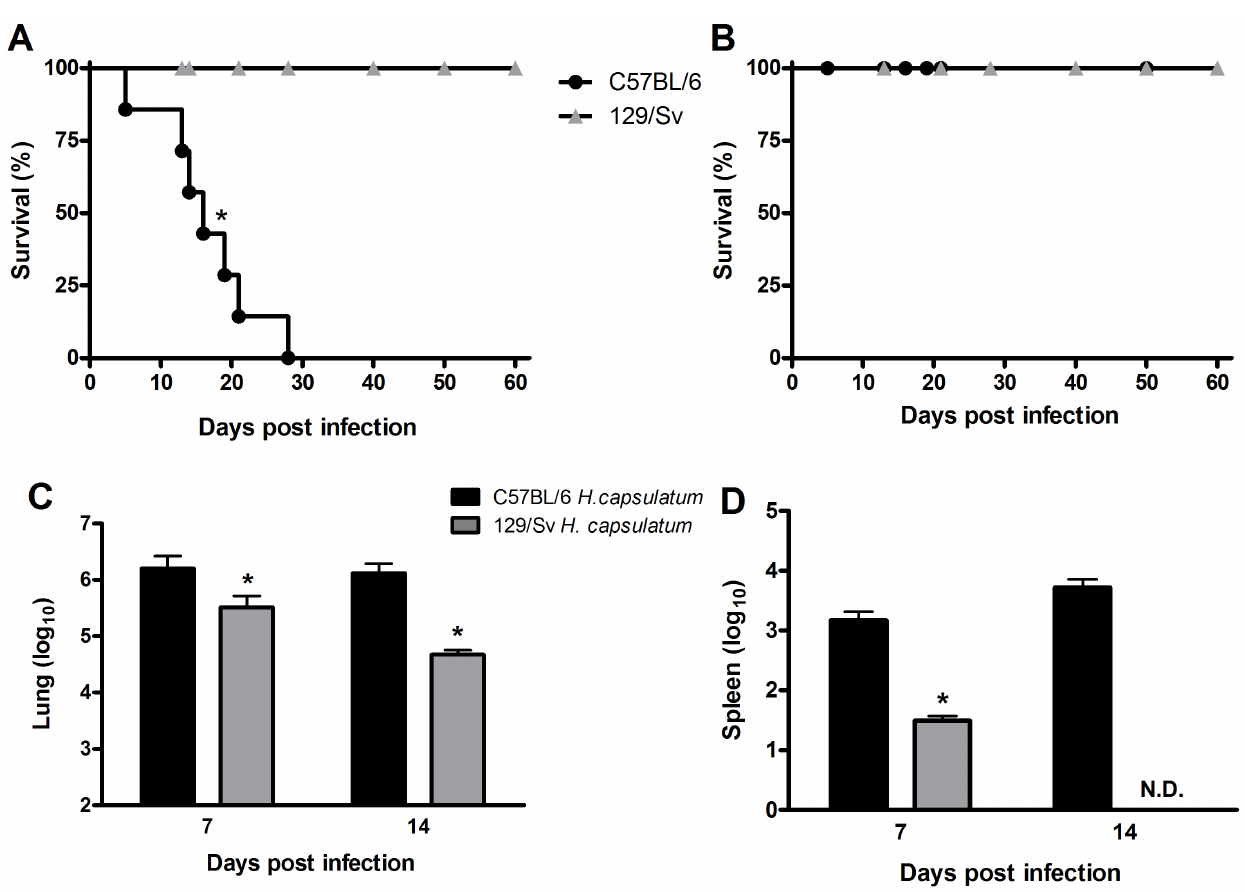
Figure 1. Survival rate and fungal burden in H.capsulatum -infected C57BL/6 and 129/Sv mice. C57BL/6 and sv129 mice were infected i.t. with 1 6 10 6 (A) or 5 6 10 5 (B) yeast cells, and their survival was followed for 60 days (n=6). The fungal loads in the lungs (C) and spleen (D) of mice infected with 5 6 10 5 yeast cells were evaluated at 7 and 14 days post- H. capsulatum infection. The data are expressed as the mean 6 SEM from one representative experiment of a total of three experiments (n=6/each experiment). *sv129 compared with C57BL/6. p , 0.05 was considered significant.